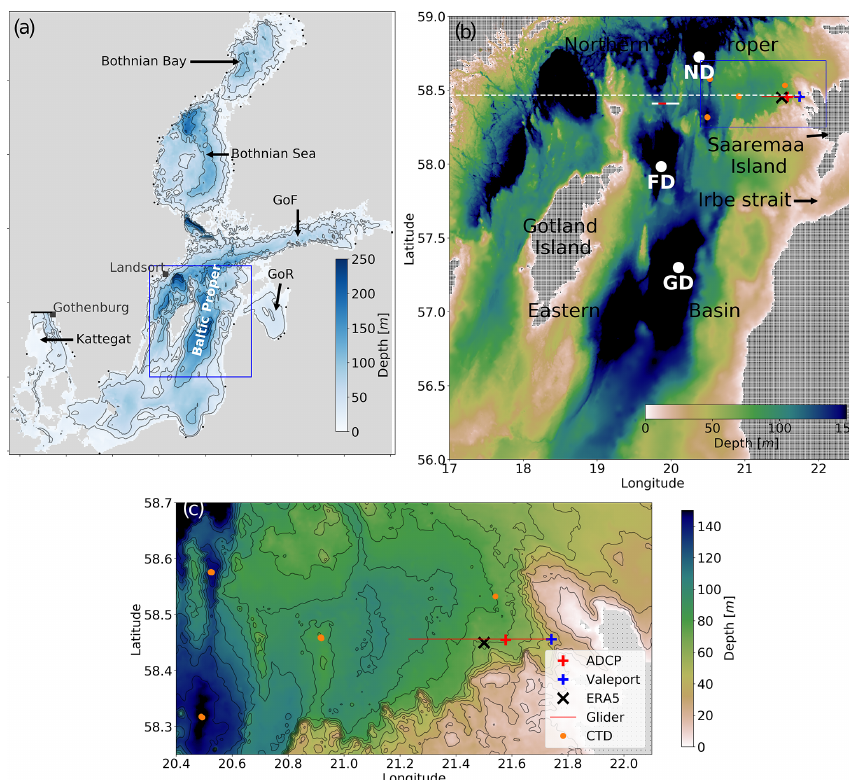
Figure 1. (a) Map of the Baltic Sea and model domain. Shown are the locations of the open boundary of the model domain at the Kattegat (bold black line), Landsort, and Gothenburg sea level stations, as well as the Baltic Sea rivers used in the model (black dots) and study area (blue box). (b) Close-up of the study area. Locations of ADCP and Valeport moorings, CTD measurements, glider section, the center of the cell of ERA5 wind data, and zonal section along the latitude of the ADCP location in the northern Baltic Proper (white dashed line) are presented. Gotland Deep (GD), Fårö Deep (FD), and Nothern Deep (ND) are also shown. The white line marks the section in Fig. 14a, and the red line indicates the time series calculation range for Fig. 14b and c. (c) Close view of the moorings and CTD measurement locations, glider section, and local topography. Dots on land (b – c) illustrate the model